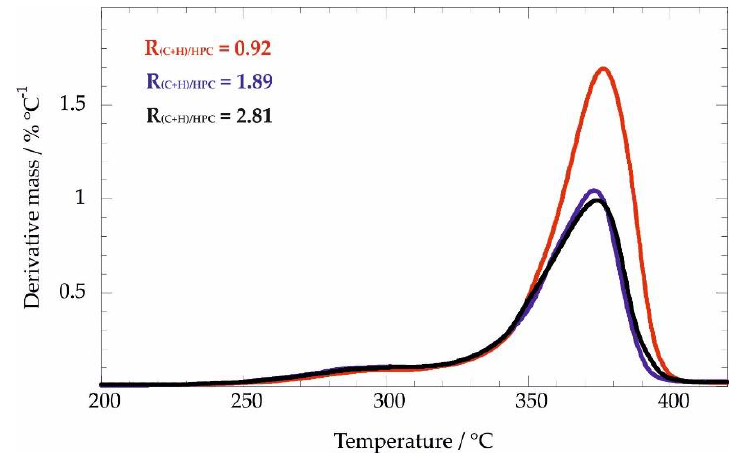
Figure 3. The differential thermogravimetric curves for the nanocomposites at variable compositions.